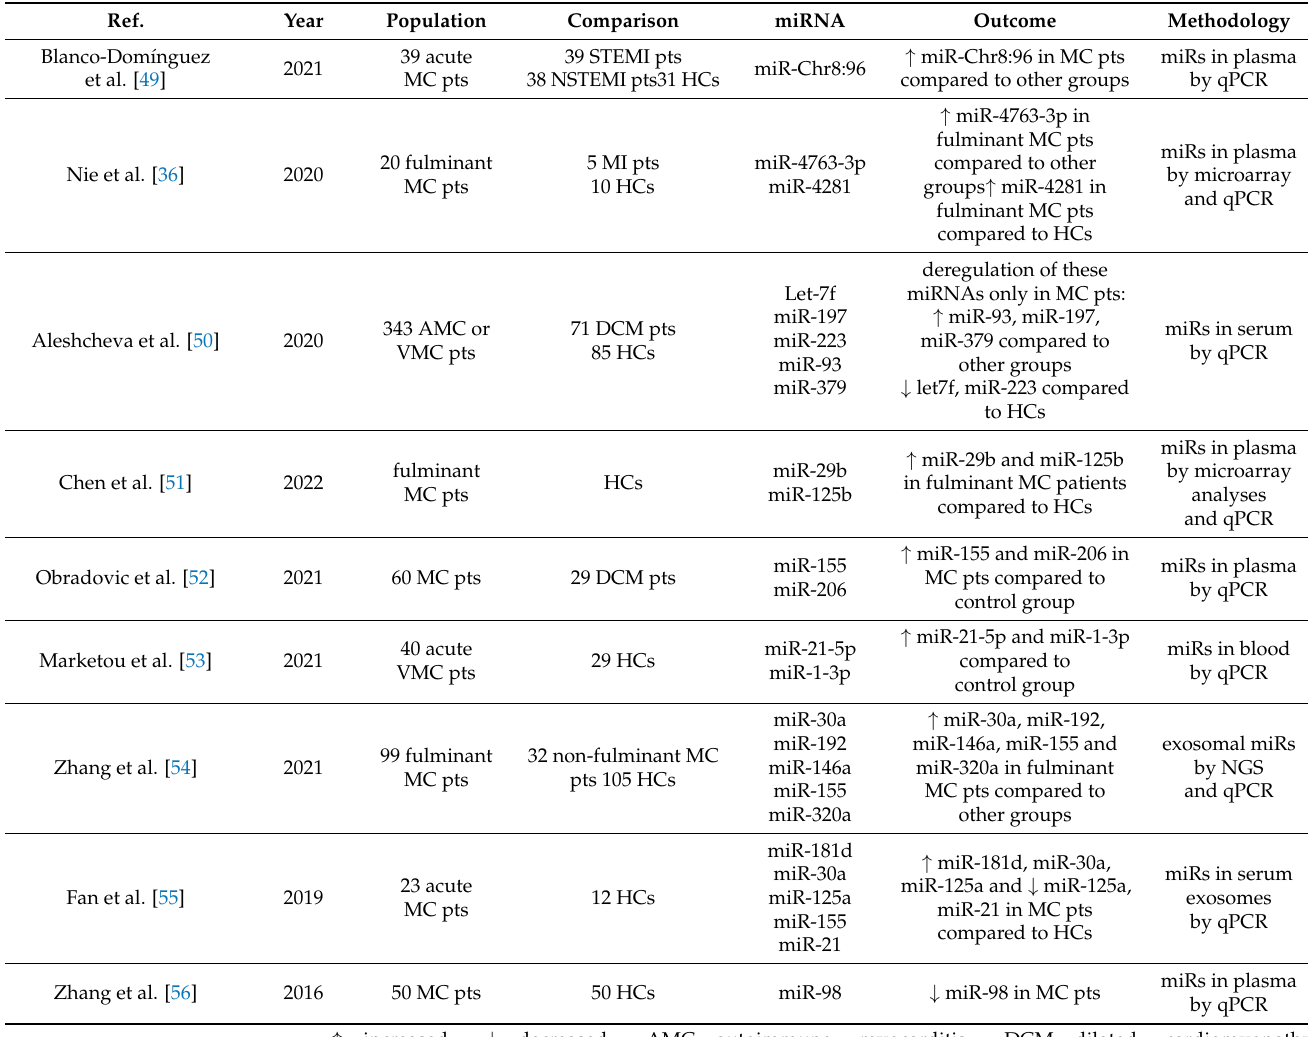
Table 3. Summary of recent studies regarding circulating microRNAs in adult myocarditis